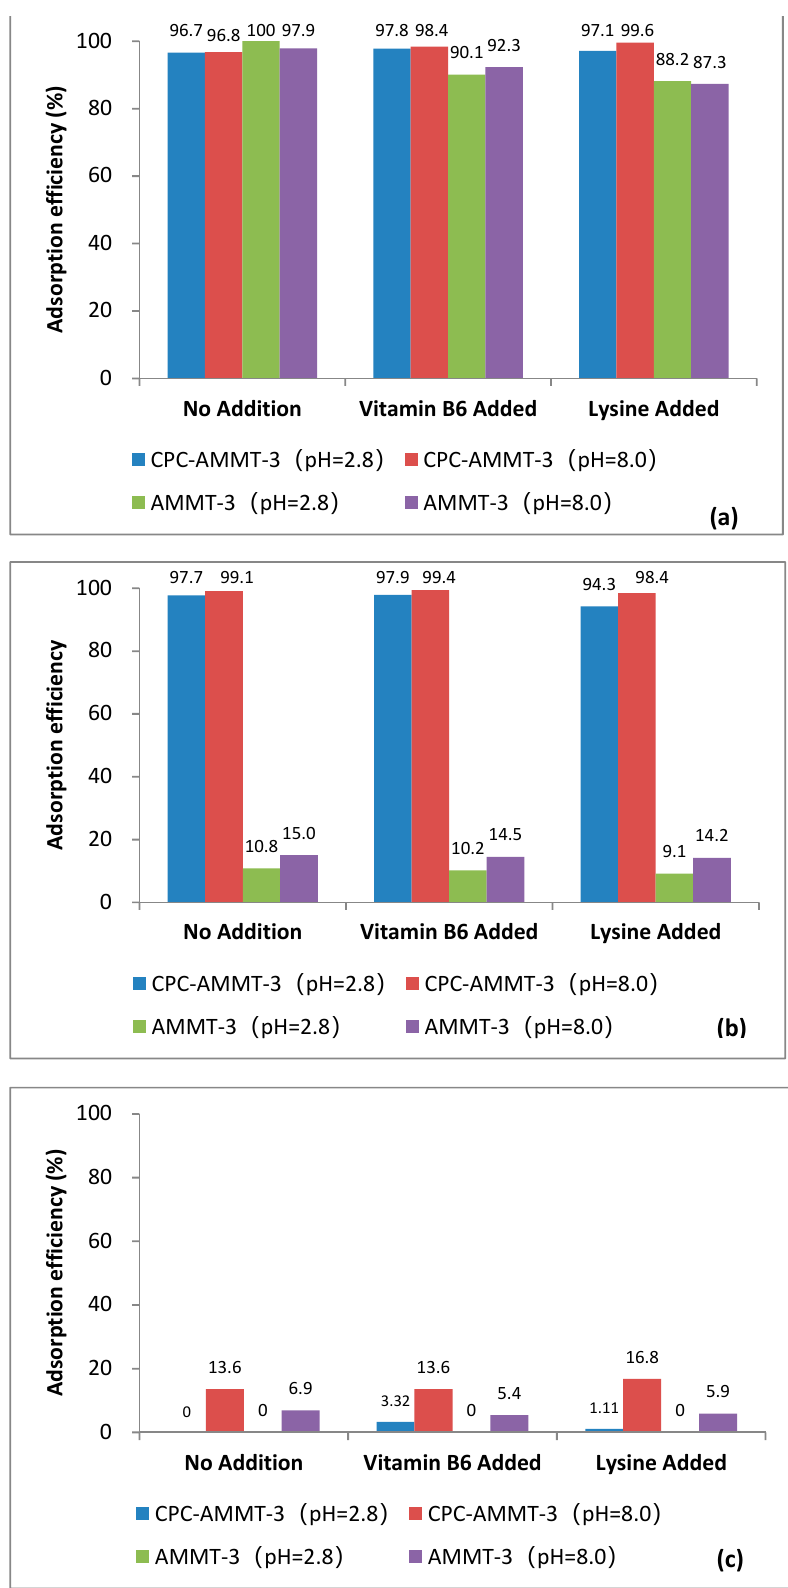
Figure 7. Adsorption efficiency of AFB1 ( a ), ZEA ( b ) and DON ( c ) over AMMT-3 and CPC-AMMT-3 under the condition of vitamin B6 or lysine coexistence.